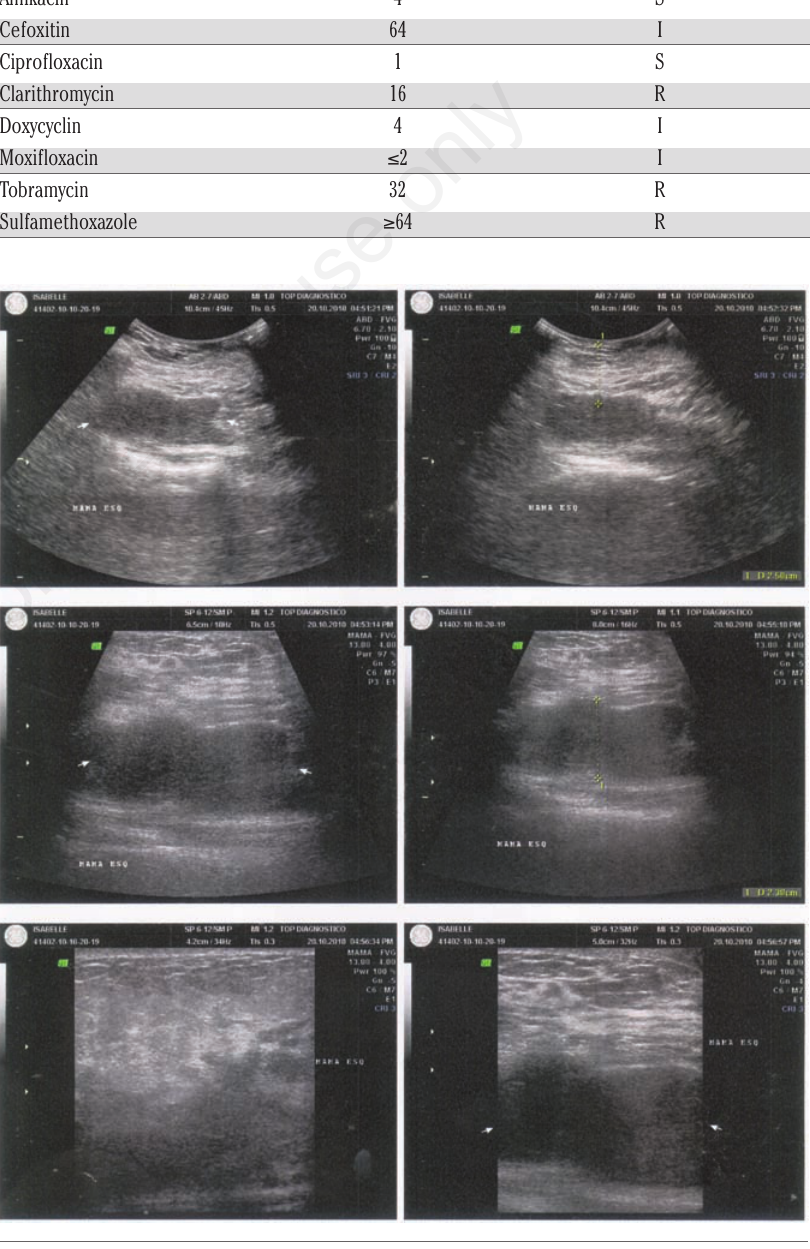
Figure 1. Left breast’s ultrasonography showing fluid